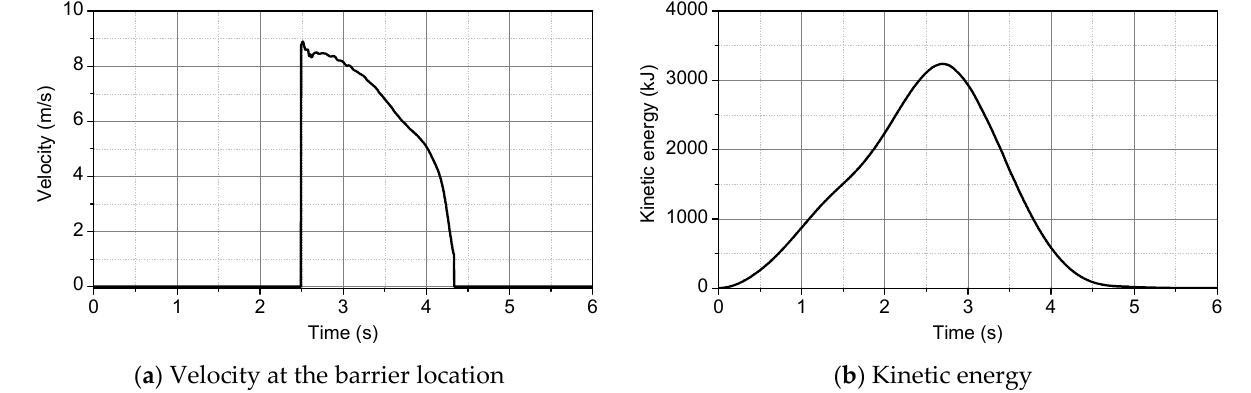
Figure 9. Moving characteristics of the landslide debris.